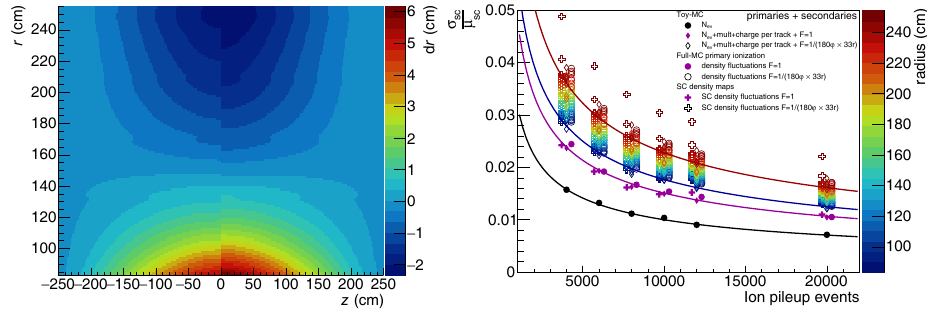
Figure 1. Left: The radial space-charge distortions d r (color axis) as a function of the radius r and the z -position. The plot shows the expectation for Pb–Pb collisions at 50 kHz and ε 10. Right: ≈ The relative space-charge density fluctuations σ SC as a function of the number of ion pile-up events, µ SC estimated from equation 1 (lines), a toy MC simulation (diamonds), a full MC simulation (circles) and a simulations based on space-charge density maps (crosses). The black markers and line represent only the contribution from the fluctuations of the number of ion pile-up events. The purple markers and line show the relative fluctuations of all contributions integrated over the full TPC volume ( F = 1). The open markers in rainbow colors illustrate the radial dependence of the fluctuations when dividing the TPC volume into small volume elements, e.g. here into 180 bins in ϕ and 33 bins in r ( F = 1 / (180 ϕ 33 r )). × The blue and red line represent the fluctuations obtained from equation 1 at the most inner and outer radius, respectively, for the same volume